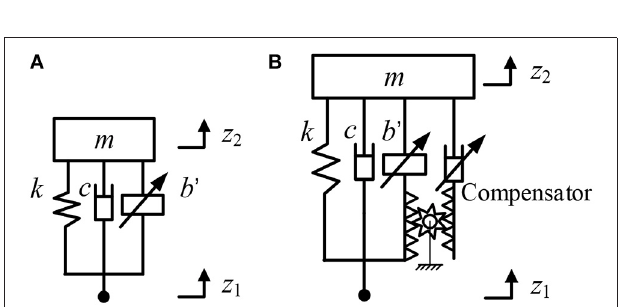
FIGURE 13 | A single-degree-of-freedom vibration control system with a SAI: (A) with no compensator and (B) with a compensator.